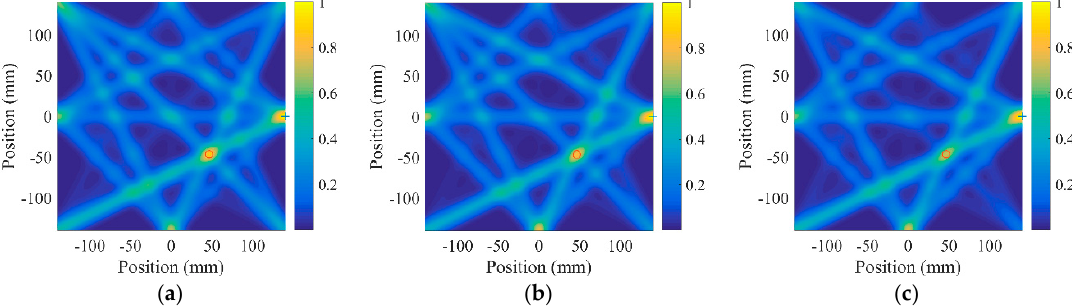
Figure 14. The traditional TRM based damage imaging results at different weight1 values ( a ) weight1 = 0.1, ( b ) weight1 = 0.2 and ( c ) weight1 = 0.3.